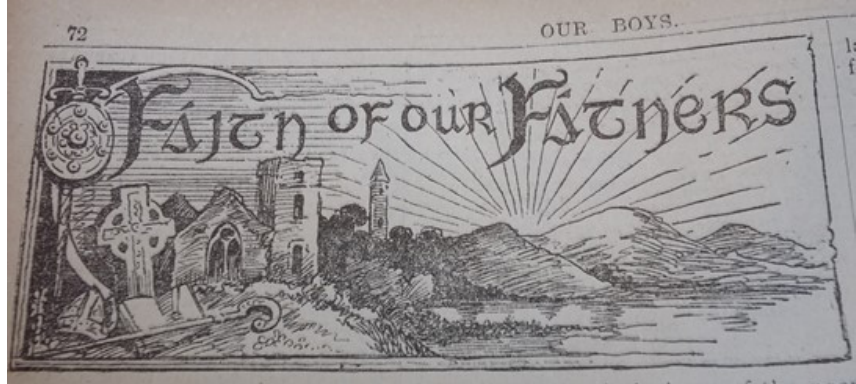
Fig. 1 Masthead of the story ‘Faith of our Fathers’ displaying all the paraphernalia of true Irishness, from round towers to Saint Patrick’s mitre to the weapons of legendary warriors. From Our Boys , 2.3 (November 1915), 72. Image